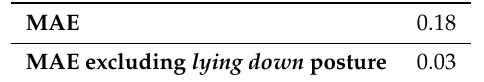
Table 11. Average counting errors of the detection component for the custom dataset.